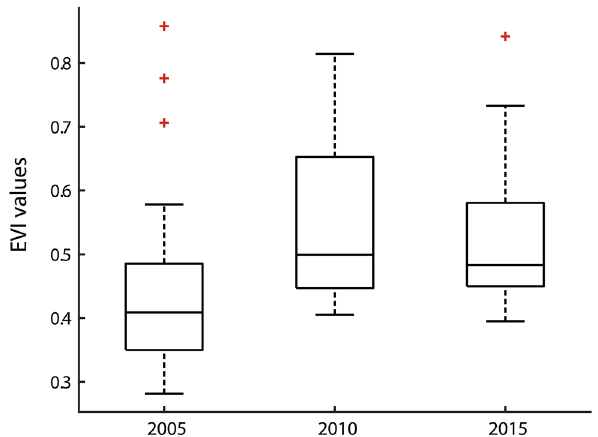
Fig. 3 Variations in ecological vulnerability index (EVI) values of Sichuan Province during the study years